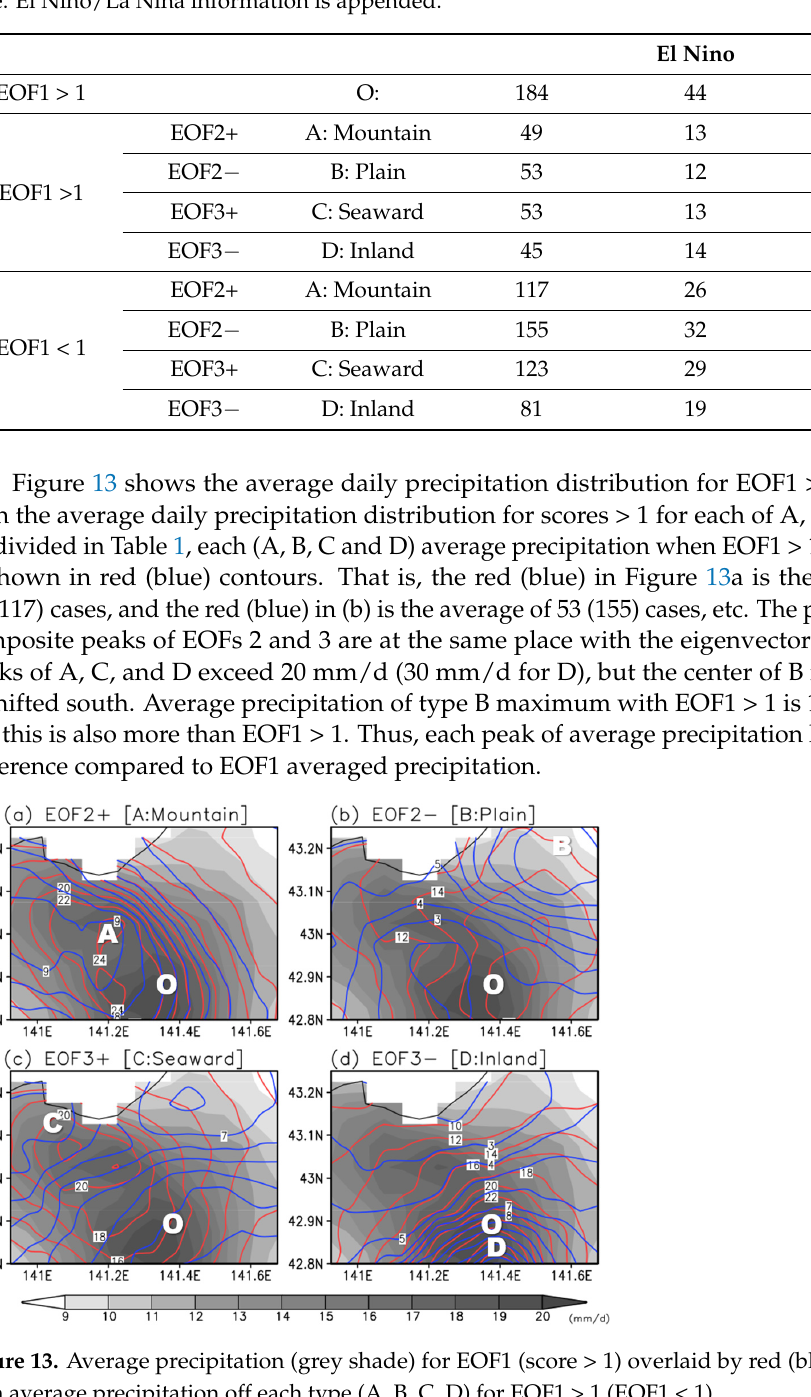
Table 1. Statistics for the occurrence of EOF1 and the number of occurrences of each precipitation type. El Niño/La Niña information is appended.